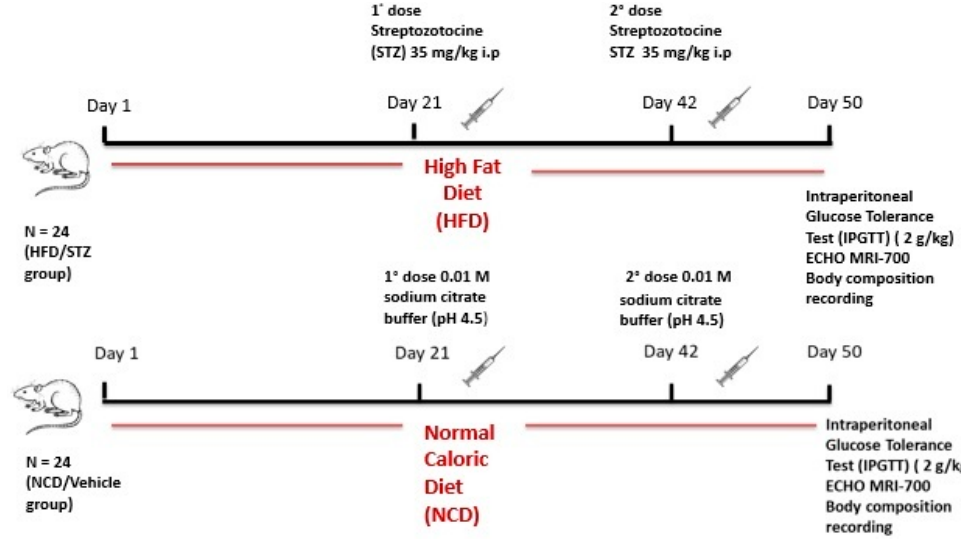
Figure 5. Schematic diagram of the experimental protocol.